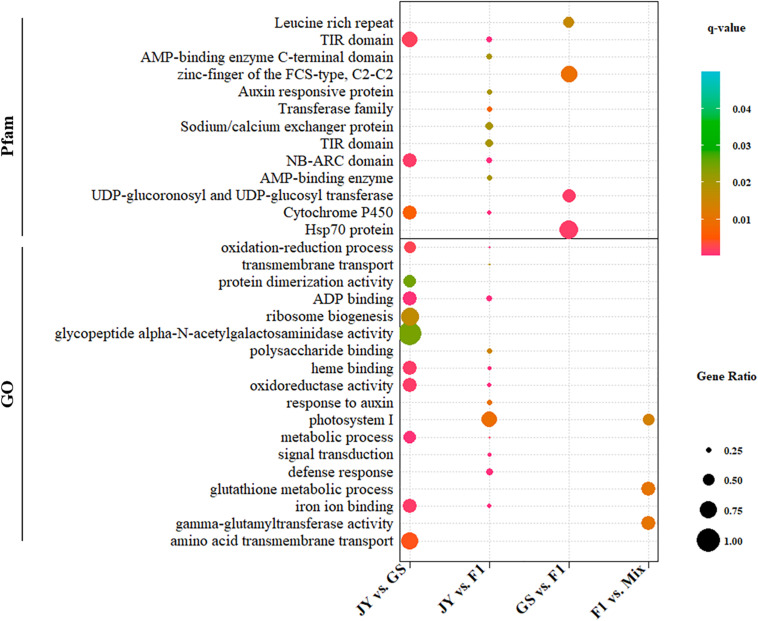
GO and Pfam enrichment of DEGs between genotypes. GO (Gene Ontology) (lower) or Pfam (upper) terms significantly (q-value < 0.05) that were over-represented in DEGs are shown. The dot size and color correspond to proportions of DEGs and the q-values.